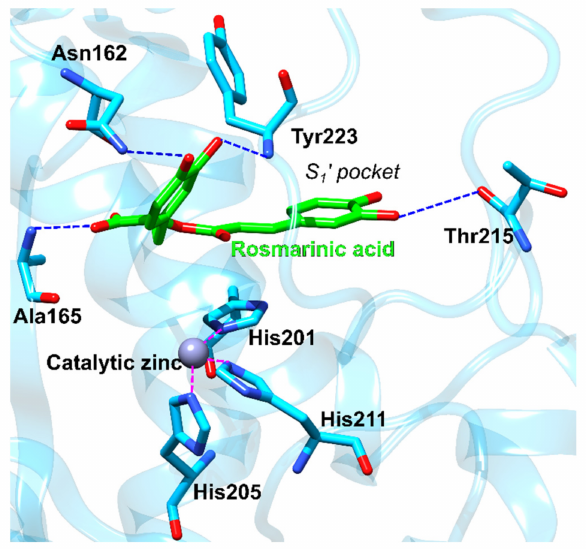
Figure 11. Rosmarinic acid docked in MMP3 (blue ribbons). The rosmarinic acid docks near the catalytic zinc ion and one of the catechol groups positions inside the S 1 (cid:48) selectivity pocket. Important amino acid residues are shown in blue sticks, hydrogen bonds are denoted with dotted blue lines and coordinative bonds with dotted purple